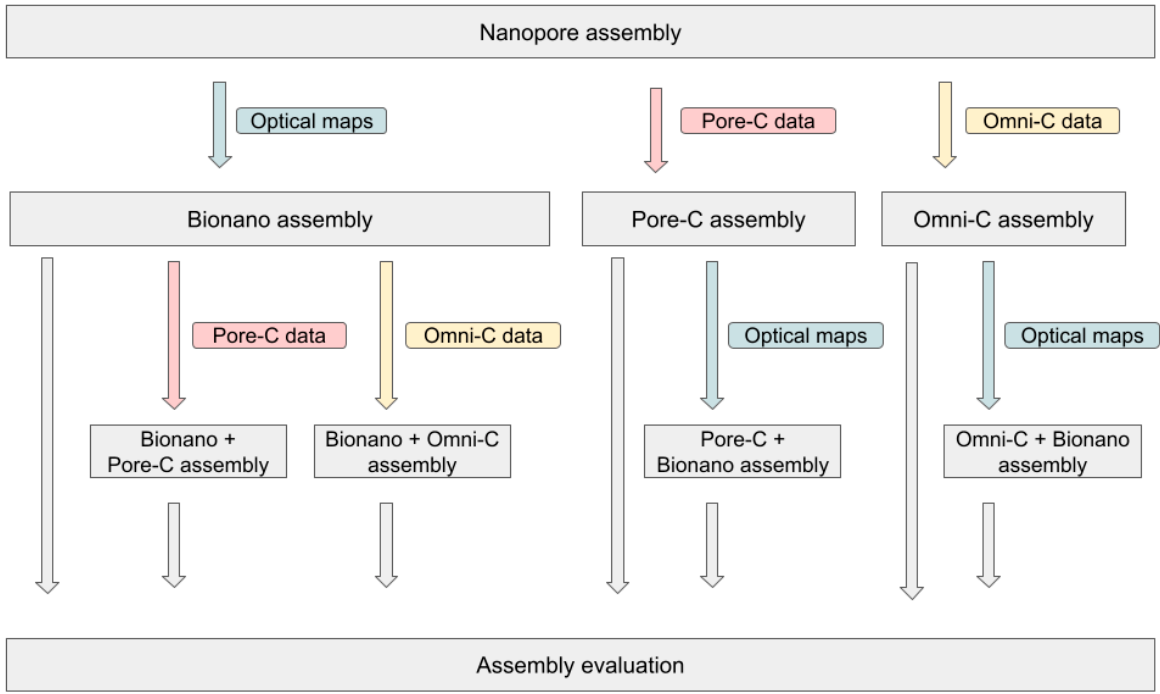
Figure 1. Global view of the different scaffolding experiments. Different scaffolding techniques were applied to the polished Nanopore contigs. Single-technology strategies were first tested. These include Bionano, Omni-C, and Pore-C scaffolding. In a second phase, scaffolds obtained previously were scaffolded again using a different method. In particular, Bionano scaffolds were super-scaffolded using either Pore-C (BNG + Pore-C) or Omni-C (BNG + Omni-C). Pore-C and Omni-C scaffolds were super-scaffolded using Bionano optical maps (respectively, Pore-C + BNG and Omni-C + BNG). Table 2. Metrics of scaffolds generated by using a combination of different scaffolding technologies, compared to input contigs. Statistics were generated using sequences of more than 30 kb in size.